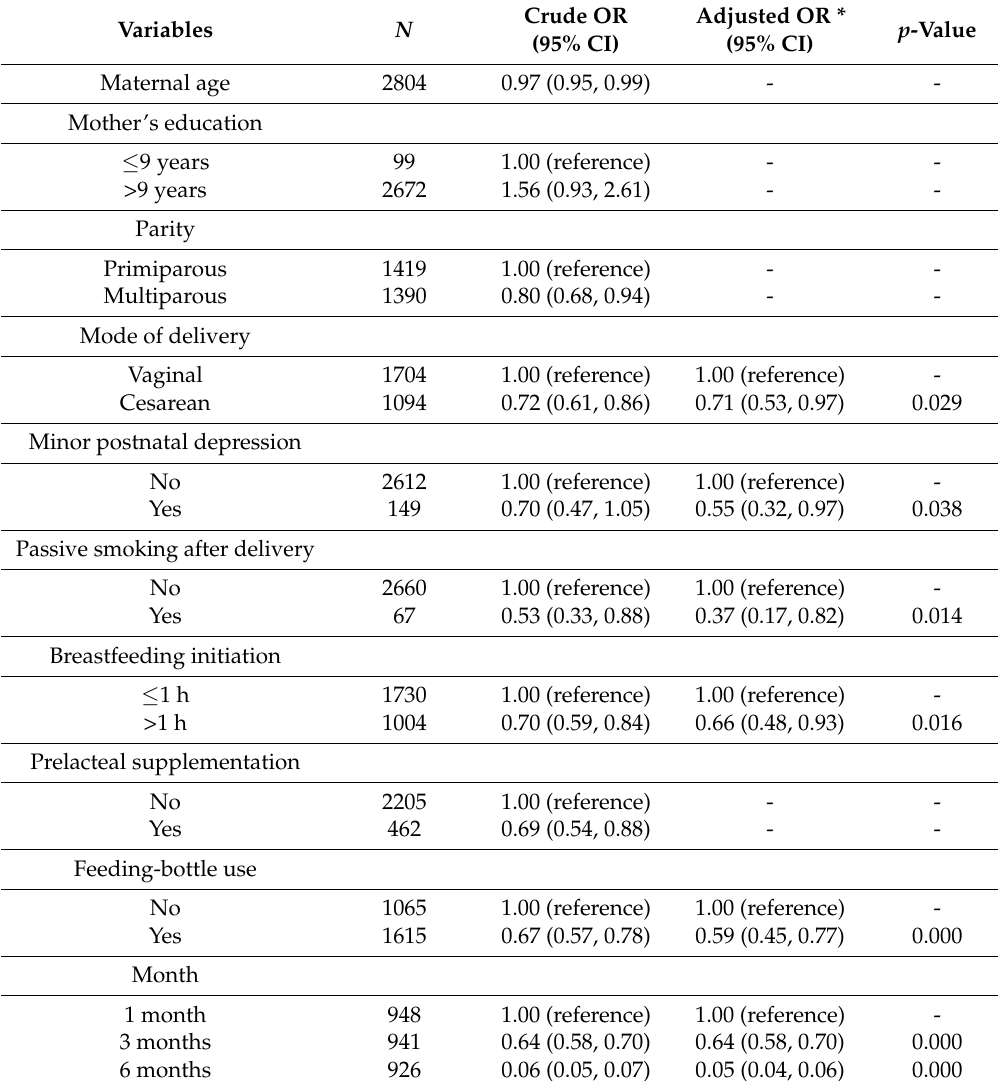
Table 3. Modifiable individual factors affecting exclusive breastfeeding